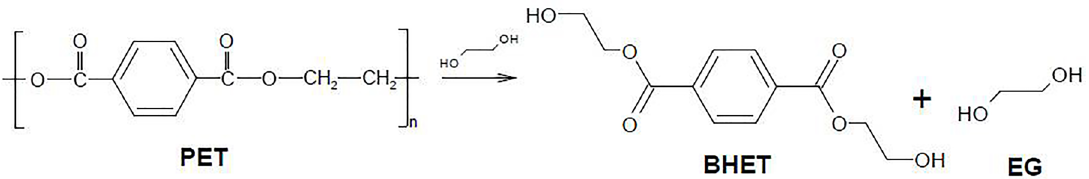
Figure 1. Reaction of PET depolymerization by glycolysis.